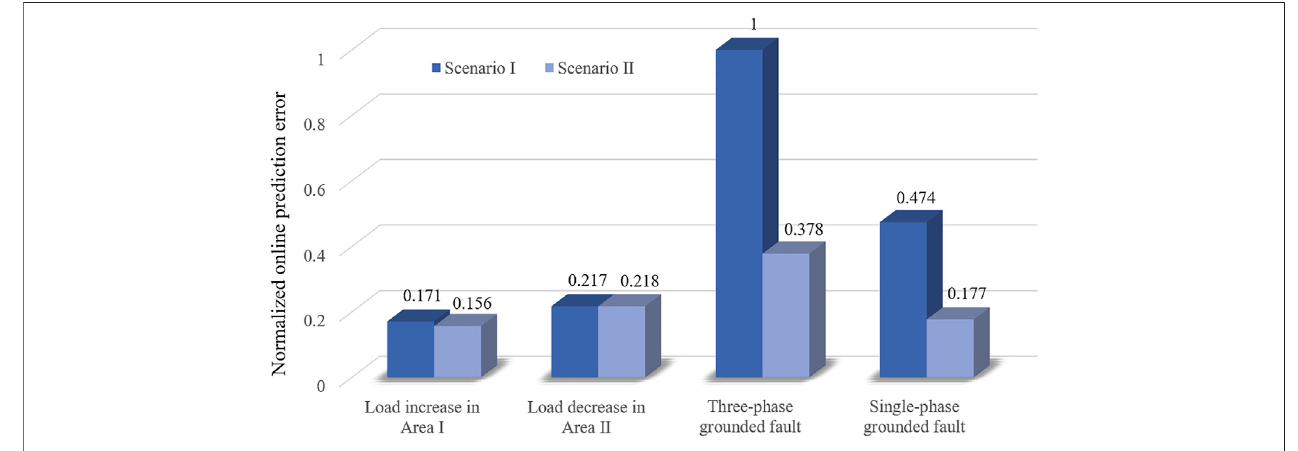
FIGURE 10 | Normalized online prediction error of LSTM in Scenario I and Scenario